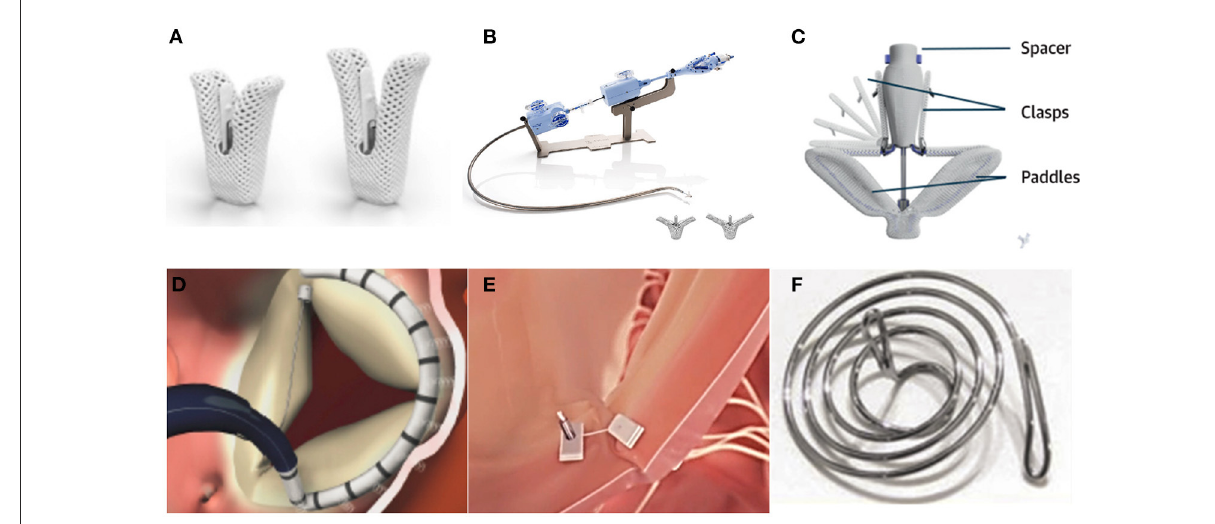
FIGURE2 TTV repair devices under clinical evaluation. (A) TriClip device with standard and long-length arm [reprinted from Wong et al. (25) with permission from the publisher]. (B) TriClip delivery system. (C) PASCAL device [reprinted from ( 14) with permission from the publisher]. (D) Cardioband device [reprinted from (26) with permission from the publisher]. (E) Trialign device [reprinted from (22) with permission from the publisher]. (F) Mistral device [reprinted from (27) with permission from the publisher].